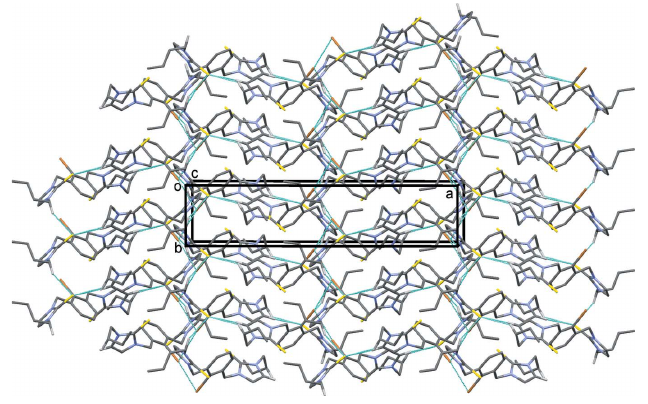
Figure 3 A view along the c axis of the crystal packing of the title compound. The Br (cid:2)(cid:2)(cid:2) Br and C—H (cid:2)(cid:2)(cid:2) Se interactions are shown as dashed lines (see Table 1). For the disordered n -butyl substituent only the major component is shown, and, for clarity, only the H atoms involved in the C—H (cid:2)(cid:2)(cid:2) Se interactions have been included.